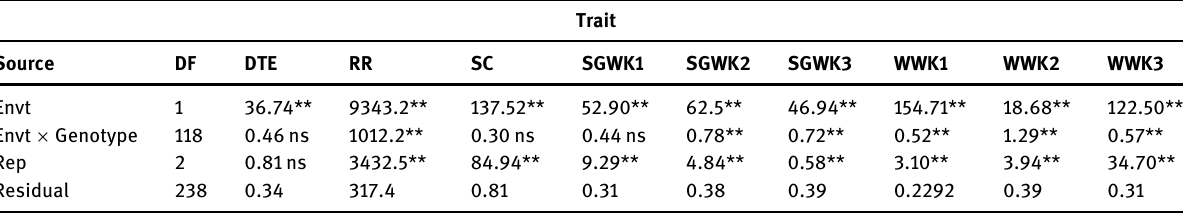
Table 2: Mean square of traits from the analysis of variance from two screen houses for 60 cowpea accessions under drought stress conditions